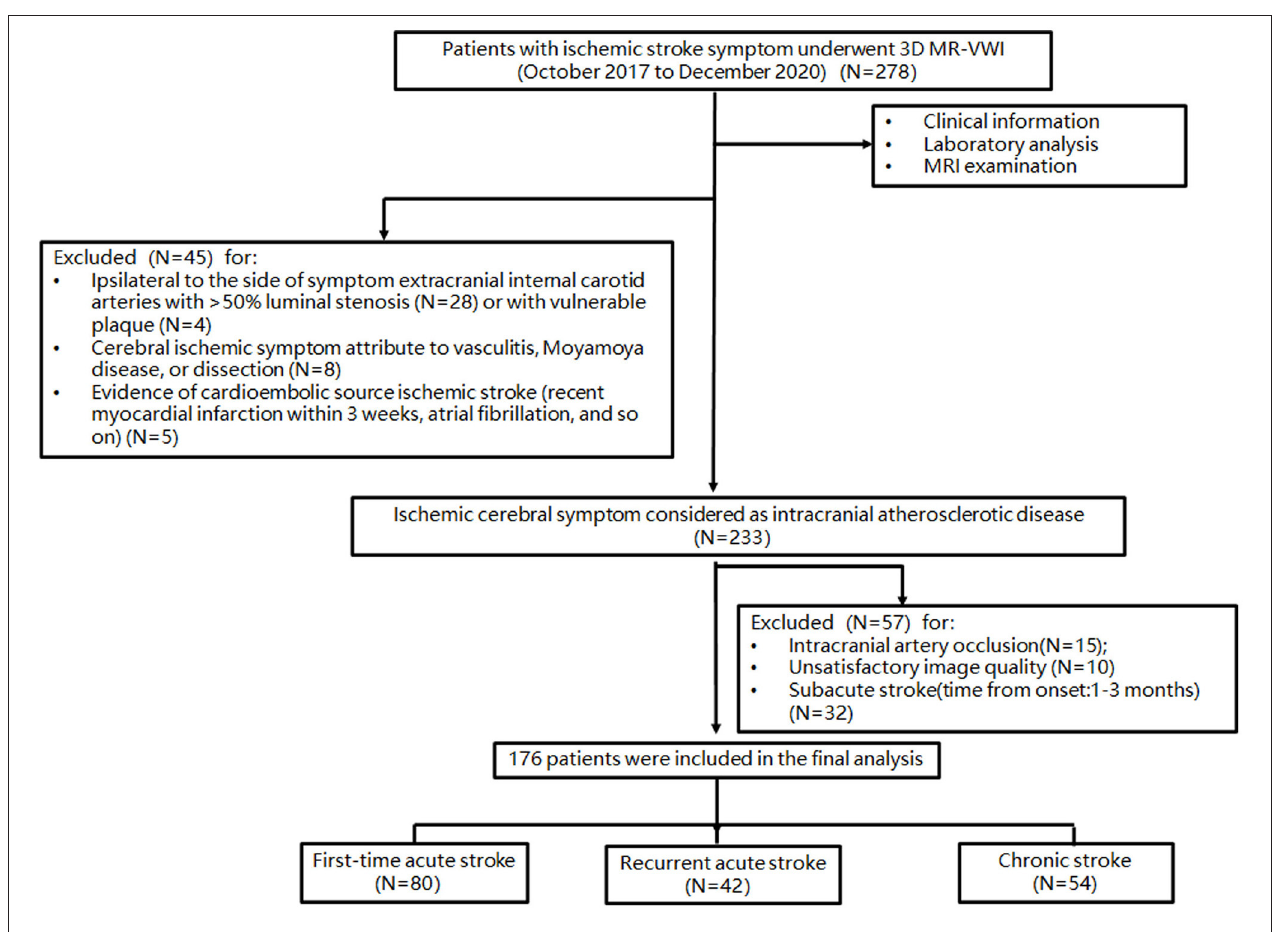
FIGURE 1 | Patient selection flow